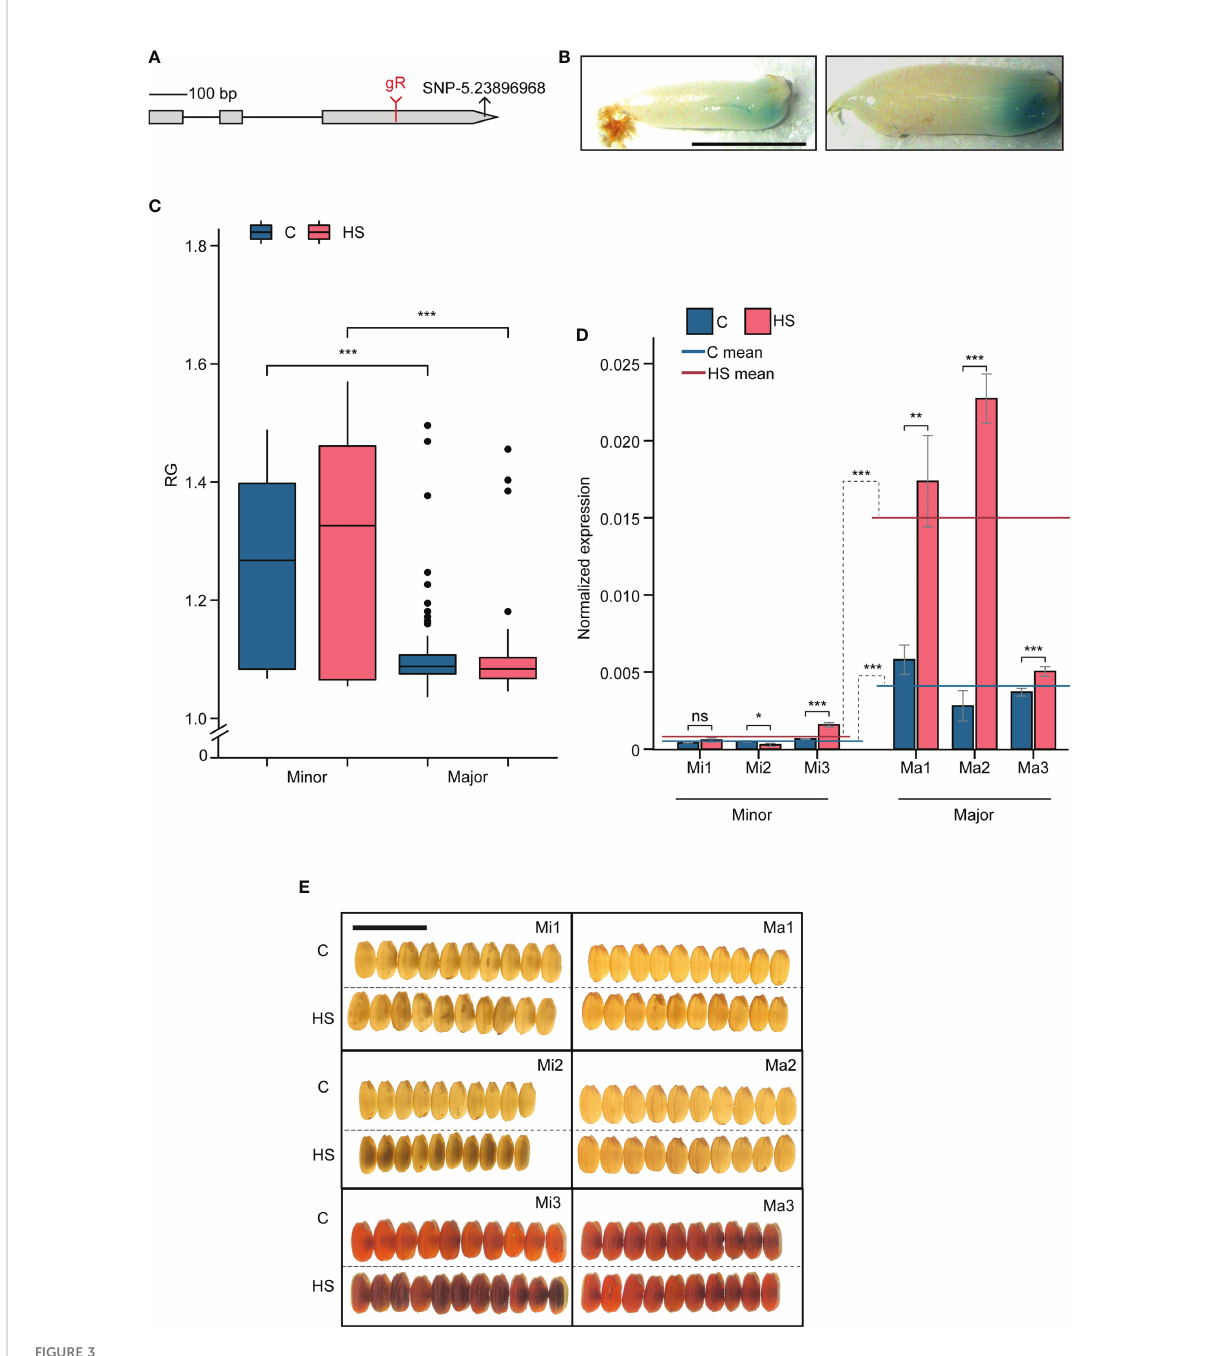
FIGURE 3 Grain chalkiness in chalky grain 5 ( OsCG5 ) allelic variants under heat stress (HS) is regulated by its transcript abundance (A) The structure of the OsCG5 gene. The position of guide RNA (gR) and SNP-5.23896968 are labeled in red and black symbols, respectively. (B) Promoter-GUS expression of OsCG5 in developing endosperm at 3 and 4 days after fertilization (DAF). Scale bar = 0.25cm (C) Distribution of the ratio of grain R and G pixel intensity (RG) of major and minor allelic accessions (Ma and Mi, respectively) under control and HS (D) RT-PCR based transcript estimation of OsCG5 in 2 DAF old grains of Ma and Mi under control and HS. Ma1-NSFTV 113; Ma2- NSFTV 333; Ma3- NSFTV 255; Mi1-NSFTV 19; Mi2- NSFTV 33; Mi3- NSFTV 345. Scale bar=1 cm. (E) Lightbox images of grains from Ma and Mi whose expression of OsCG5 transcript was estimated in (D) C and HS indicate control and heat stress, respectively. Signi fi cance level for t-test, * P <0.05; ** P <0.01; *** P <0.001; ns, non-signi fi